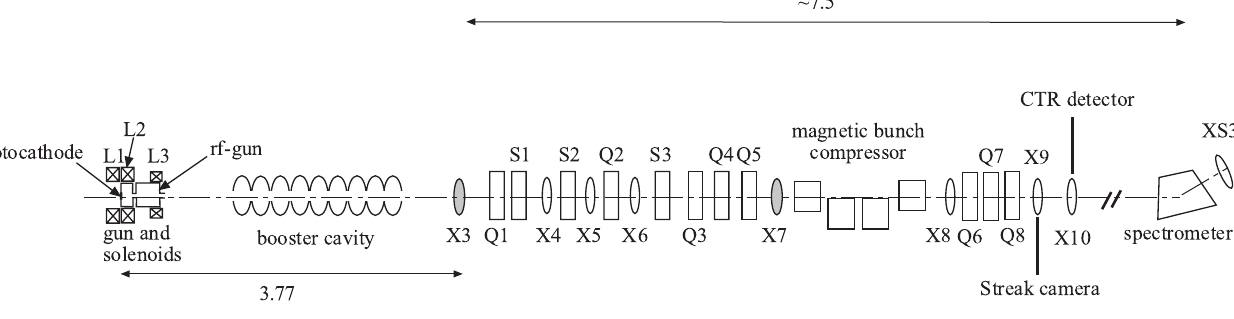
FIG. 1. Overview of the Fermilab/NICADD photoinjector. ‘‘X’’ refers to diagnostic stations (beam viewers and/or slit location), ‘‘L’’ to the solenoidal lenses, ‘‘Q’’ to quadrupoles, and ‘‘S’’ to skew quadrupoles. Distances are in meters. The magnetic bunch-compressor chicane bends the beam in the vertical plane while the spectrometer deflects the beam in the horizontal